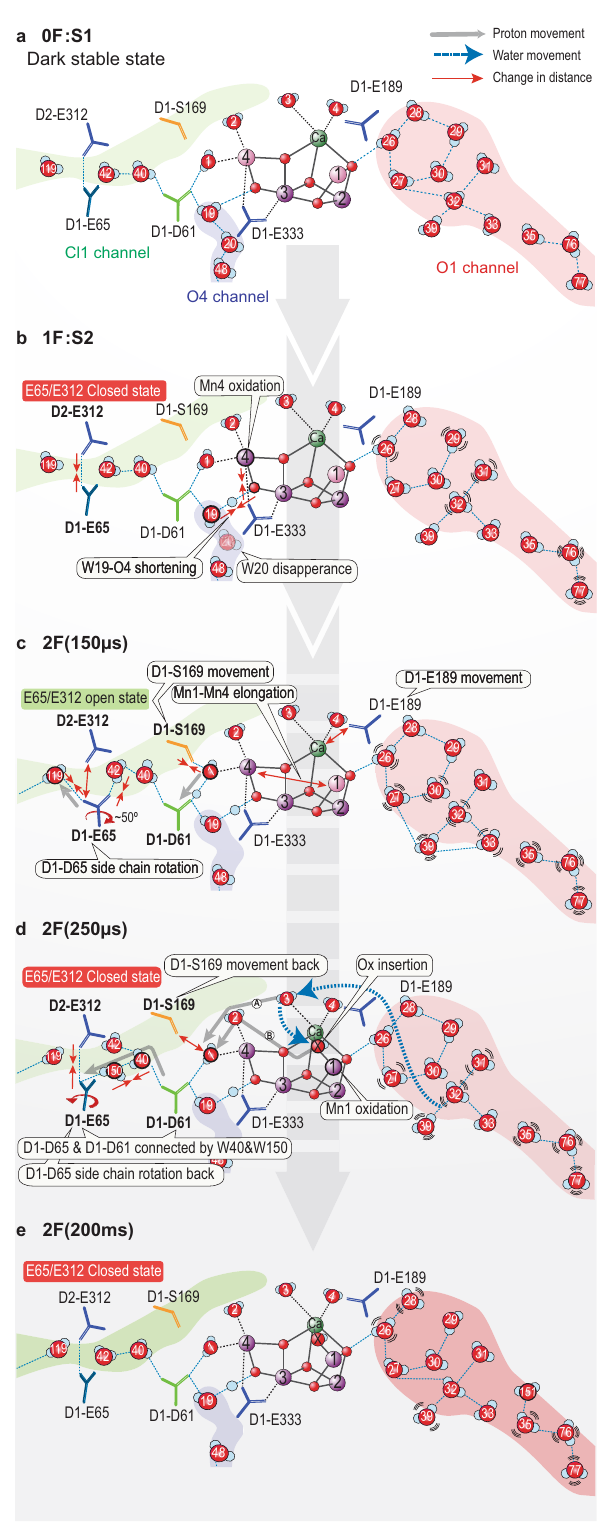
Fig. 7 Schematic summarizing the structural changes in the O1, Cl1, and O4 channels leading to the fi rst water insertion and proton release during the S 2 → S 3 transition. Mn1 and Mn4 oxidations from (III) to (IV) are shown as a color change from pink to purple. The gray arrow represents the possible proton pathway, while the blue dashed arrow represents the potential stepwise water insertion